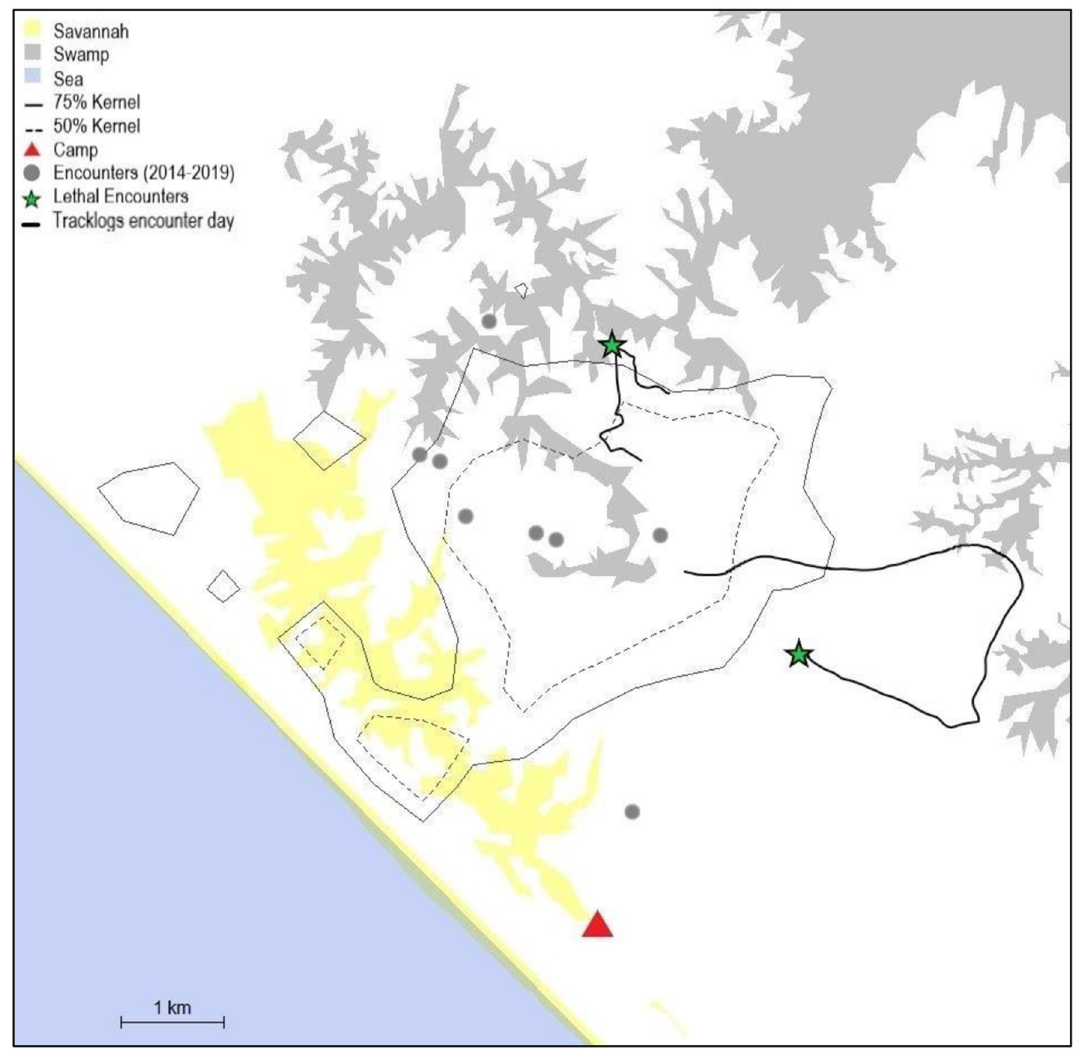
Figure 1. Map of the study area and location of events. The locations of the two lethal encounters of the 06/02/2019 and the 11/12/2019 are marked with green stars. Nine previous encounters with gorillas (2014– 2019) are marked with eight grey circles since two event locations were identical) characterized by peaceful behaviour and, in two cases, co-feeding. The 50% and 75% density isopleth 55 of the home range and travel paths based on tracklog data from the two encounter days are marked in broken grey, solid grey and black lines. The figure was generated in R (version 3.6.3, R Core team, https:// www.R- proje ct. org/) 56 using the package adehabitatHR 57